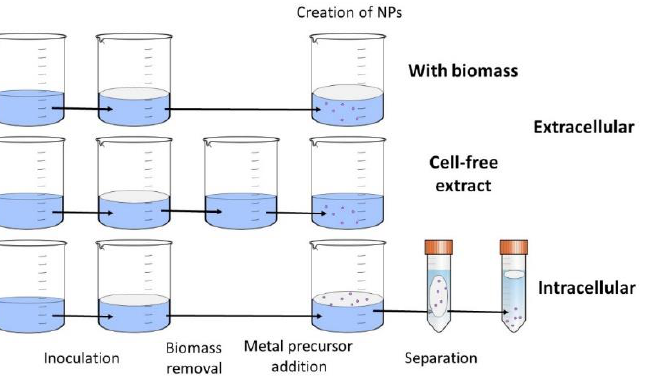
Figure 8. Intracellular and extracellular synthesis of nanoparticles by fungi.